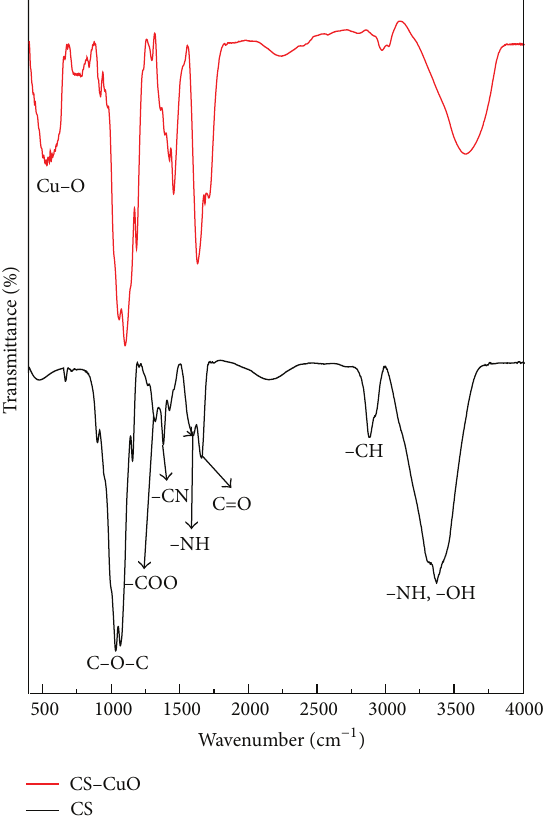
Figure 1: FT-IR spectra of CS and CS-CuO hybrid.